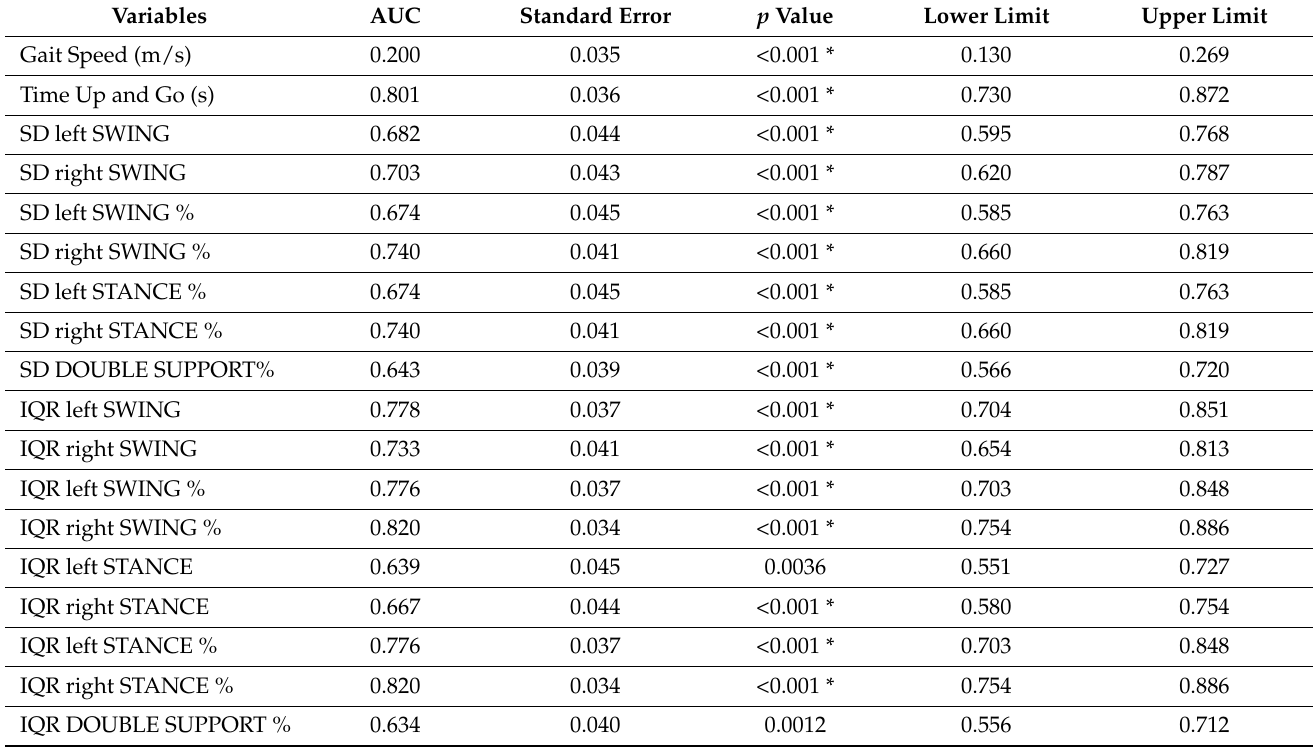
Table 4. ROC analysis of statistically significant kinematic features.